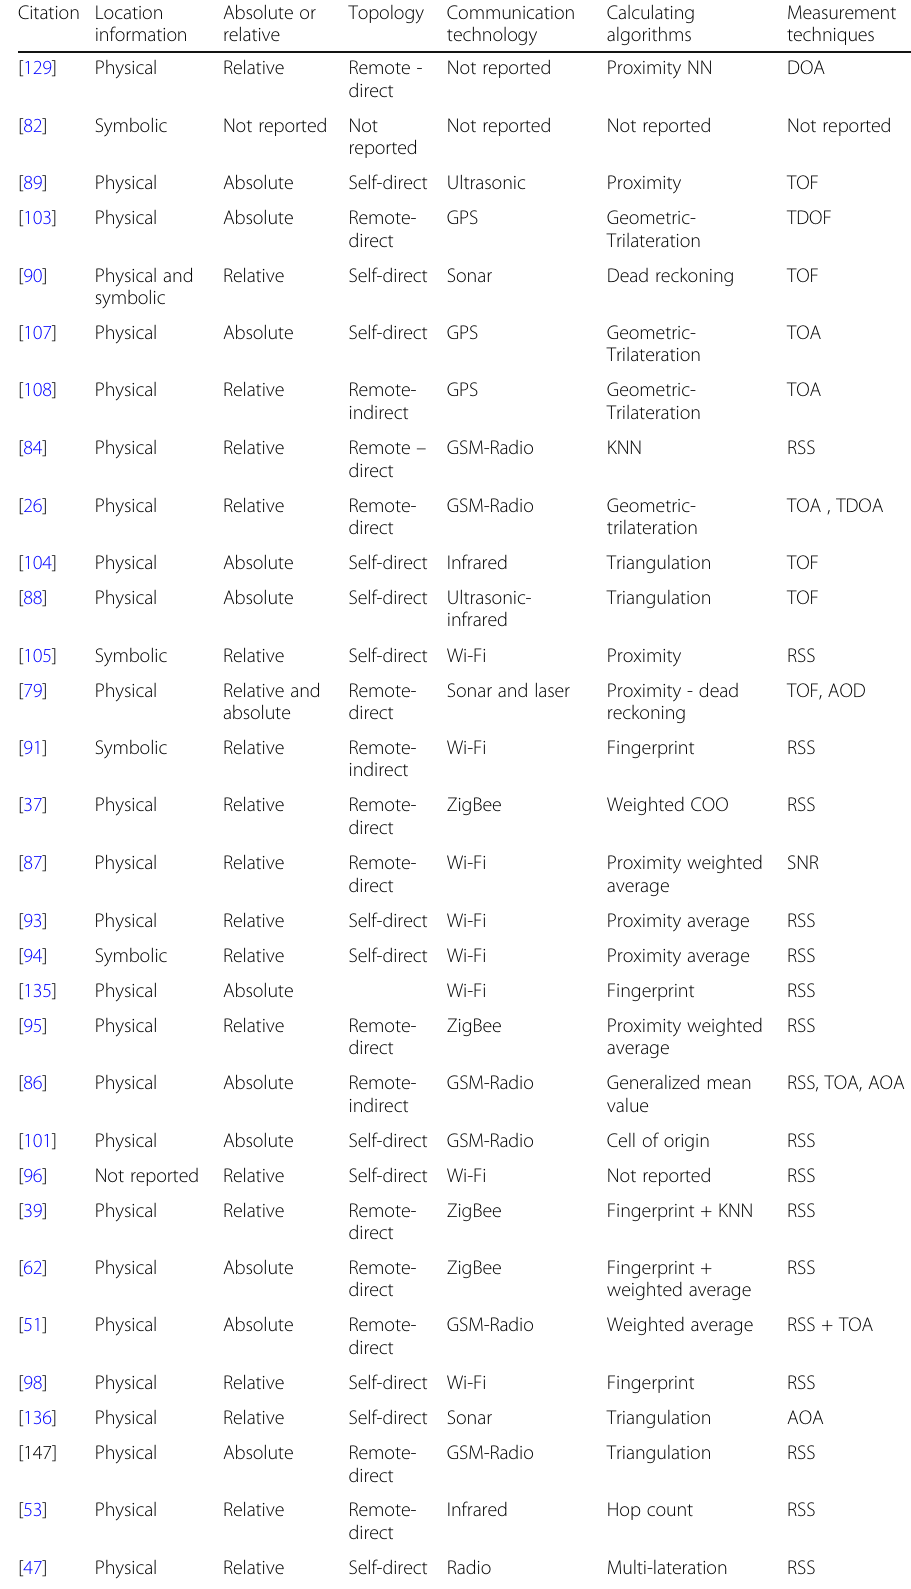
Table 5 The positioning metrics Citation Location